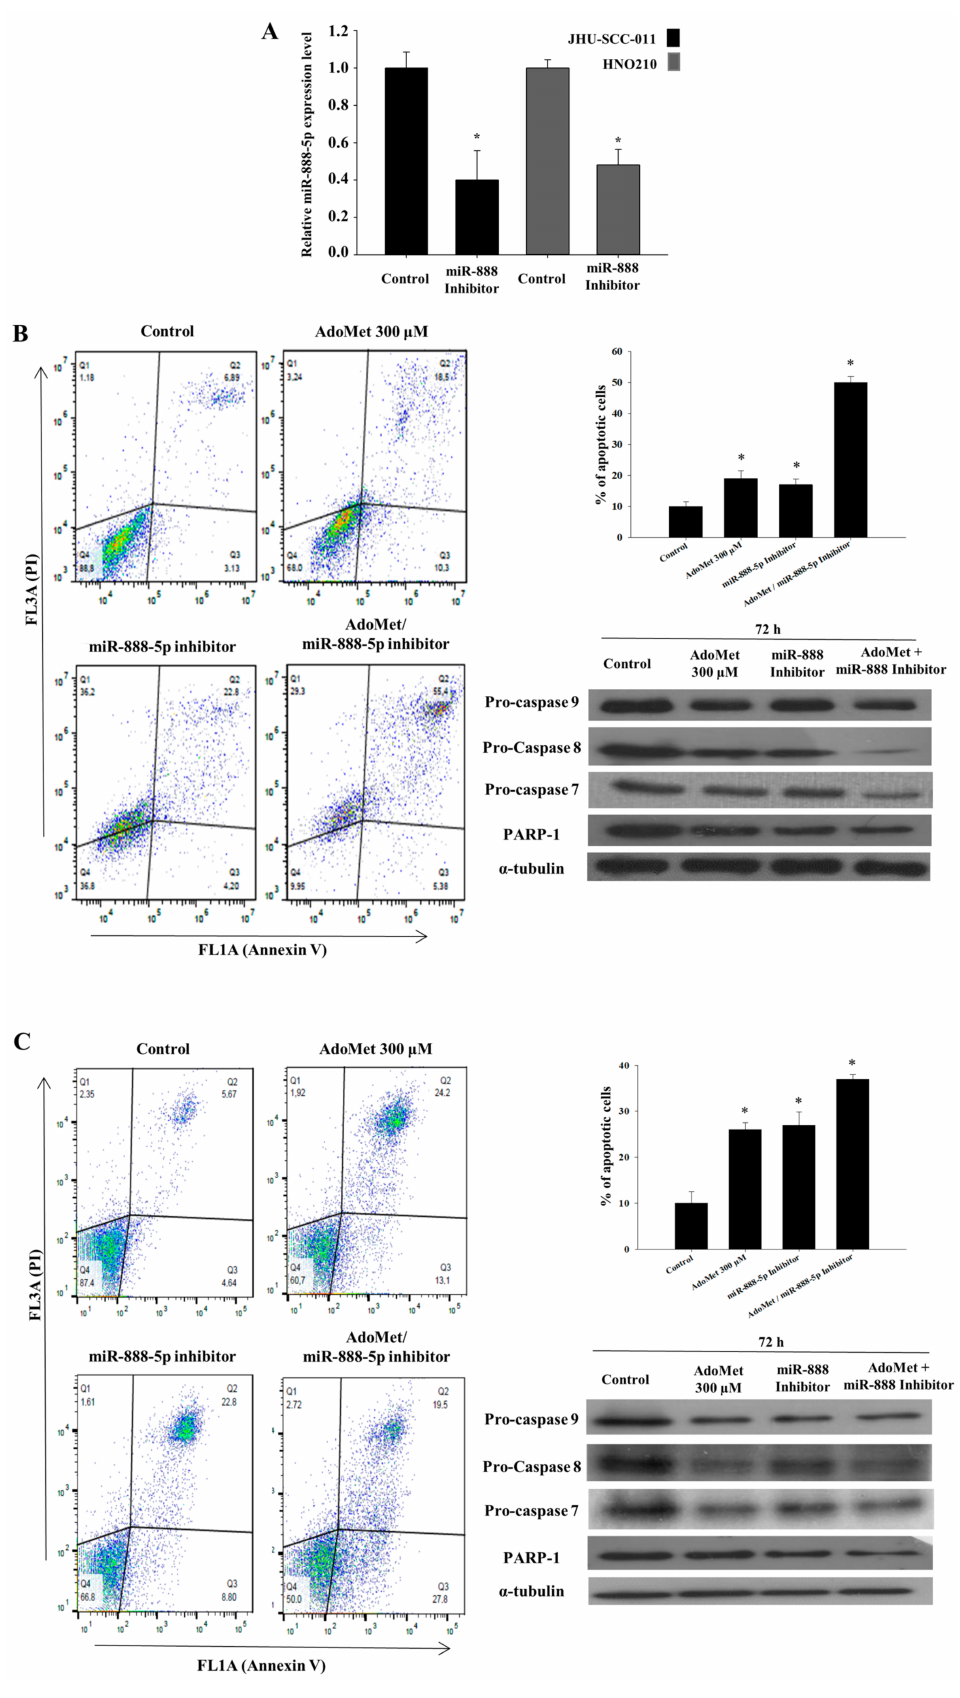
Figure 4. E ff ect of AdoMet and miR-888-5p inhibitor combination on apoptotic process in